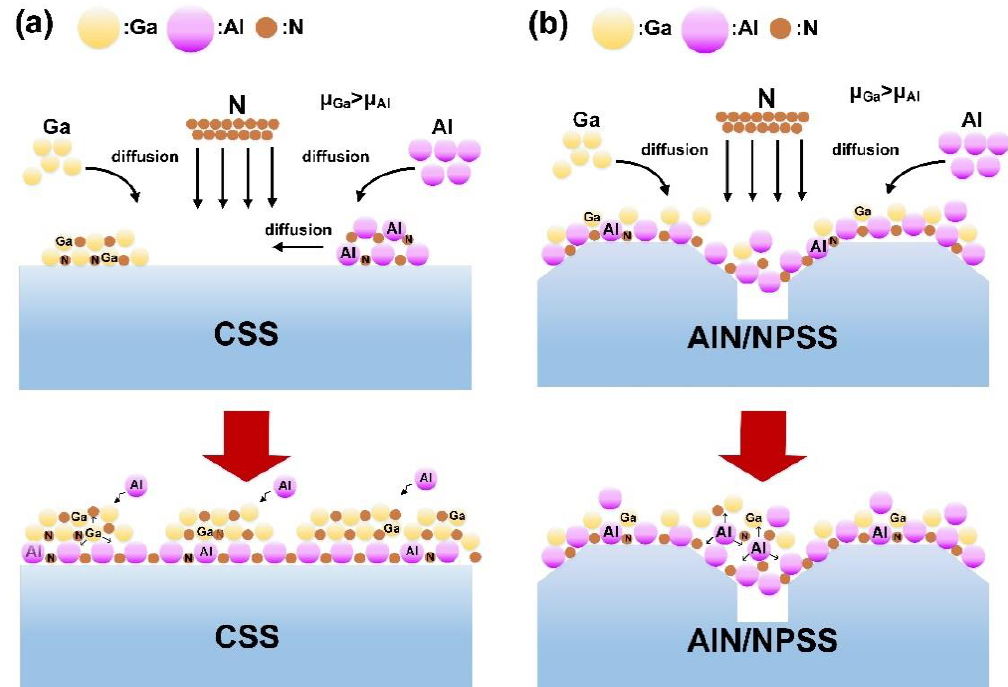
Figure 8. Schematic diagrams of the AlGaN growth mechanism on various substrates: ( a ) CSS and ( b ) AlN/NPSS.